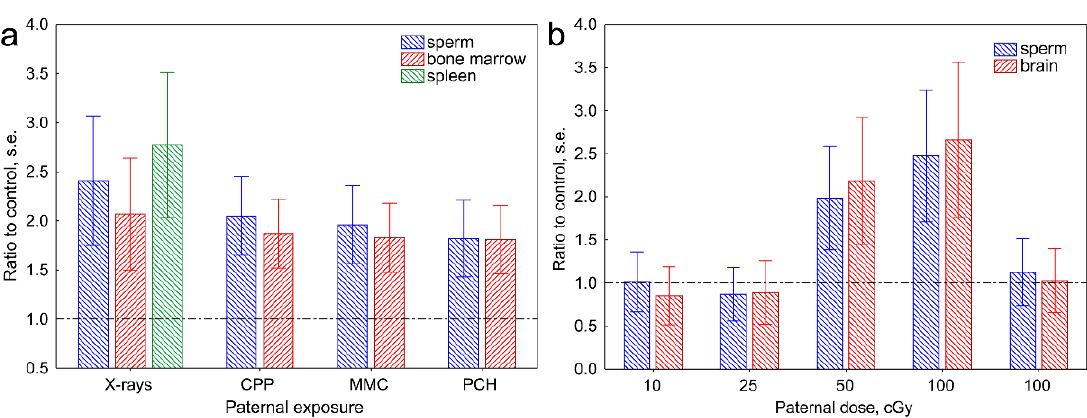
Figure 3. The transgenerational effects of paternal exposure to mutagens on ESTR mutation frequencies in the F 1 offspring of exposed male mice. ( a ) Mutation frequencies in the F 1 offspring of male mice exposed to acute X-rays, and anticancer drugs cyclophosphamide (CPP), mitomycin c (MMC), and procarbazine (PCH). Data from Reference [54]. ( b ) Dose and dose-rate effects on the manifestation of transgenerational instability in the F 1 offspring of irradiated male mice. Data from Reference [39]. On all graphs, the ratio of ESTR mutation frequencies in the offspring of exposed males to that in control animals is shown.